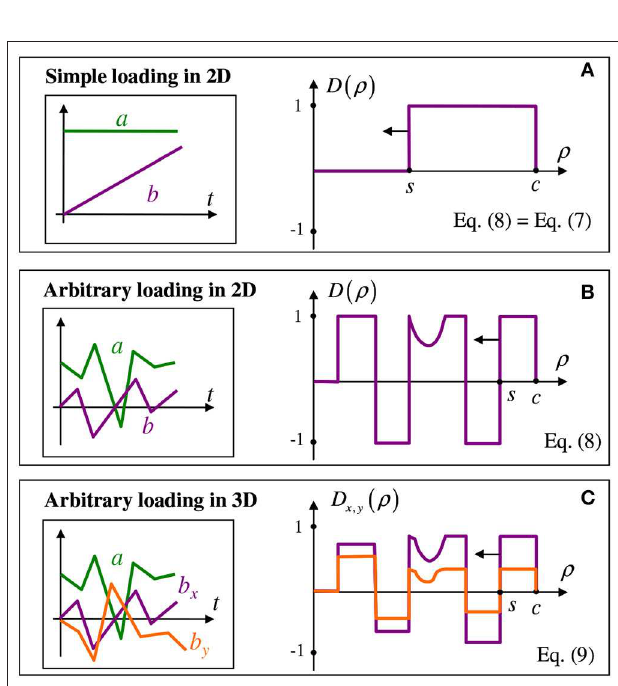
FIGURE 2 | Illustration for the MMD: loading histories at the left and memory diagrams at the right, for the simple loading (A) , arbitrary loading in 2D (B) , and in 3D (C) . Here, s <ρ< c is slip annulus, see also Figure 1